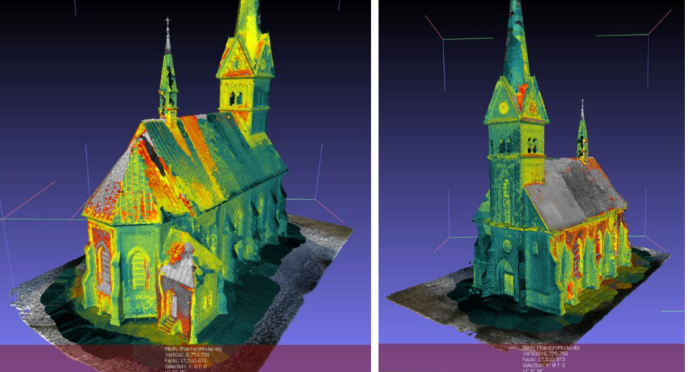
Figure 12. Integration of the RGB model with the Phantom 4 PRO with the point cloud of thermal images from the Matrice 300